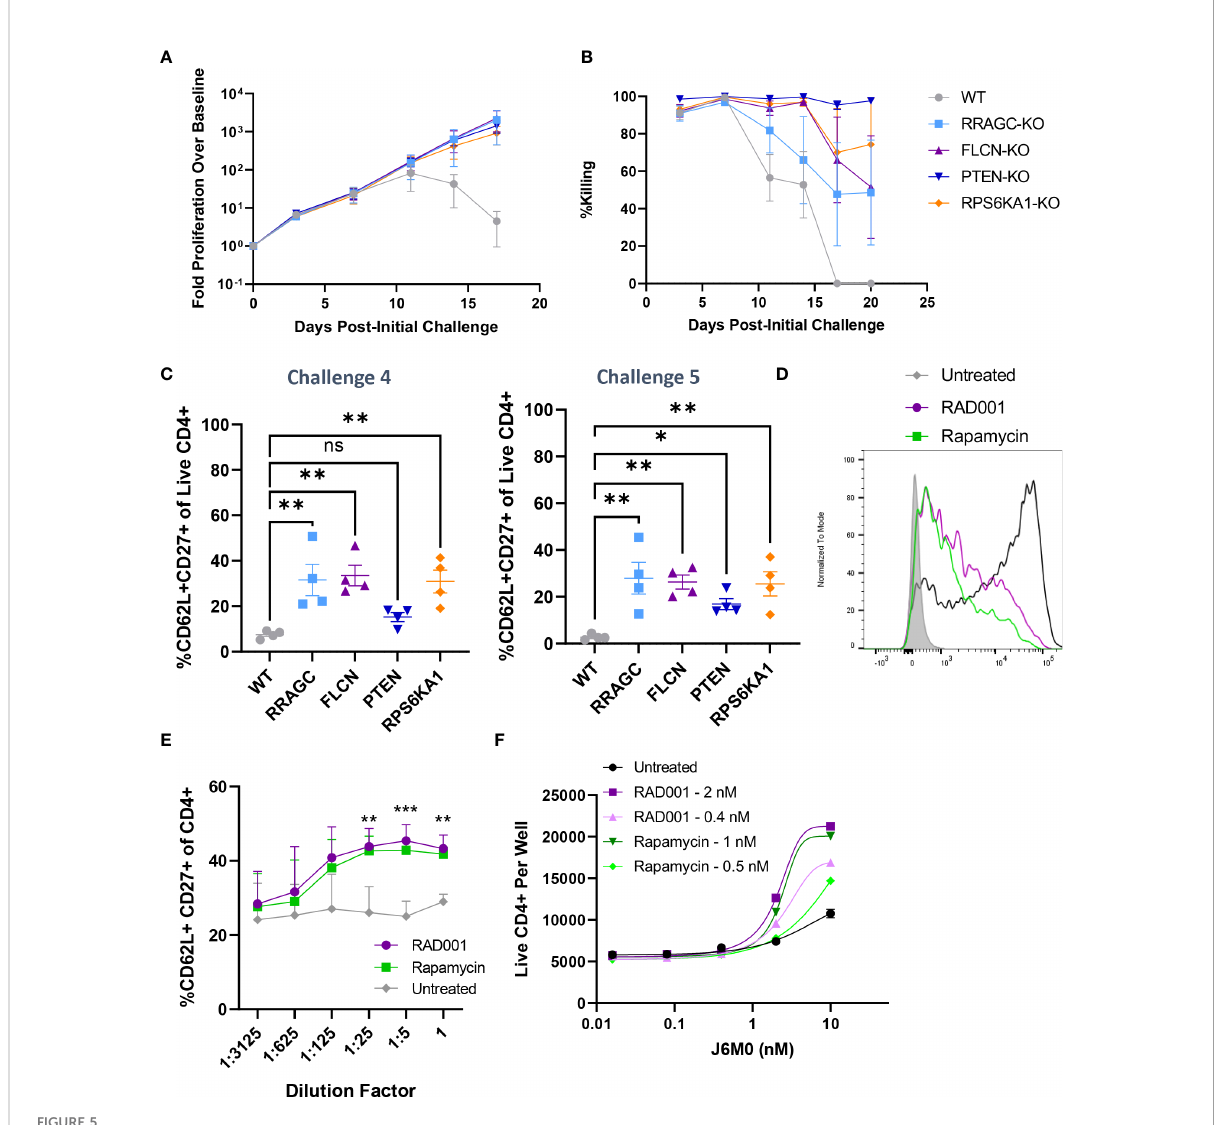
FIGURE 5 Knockout of mTOR-related genes favors memory-like cell expansion in response to BsAb-mediated challenge. (A) FLCN, RRAGC, PTEN , or RPS6KA1 were knocked out in healthy CD4+ T cells from four healthy human donors and used in a repeat challenge assay system.